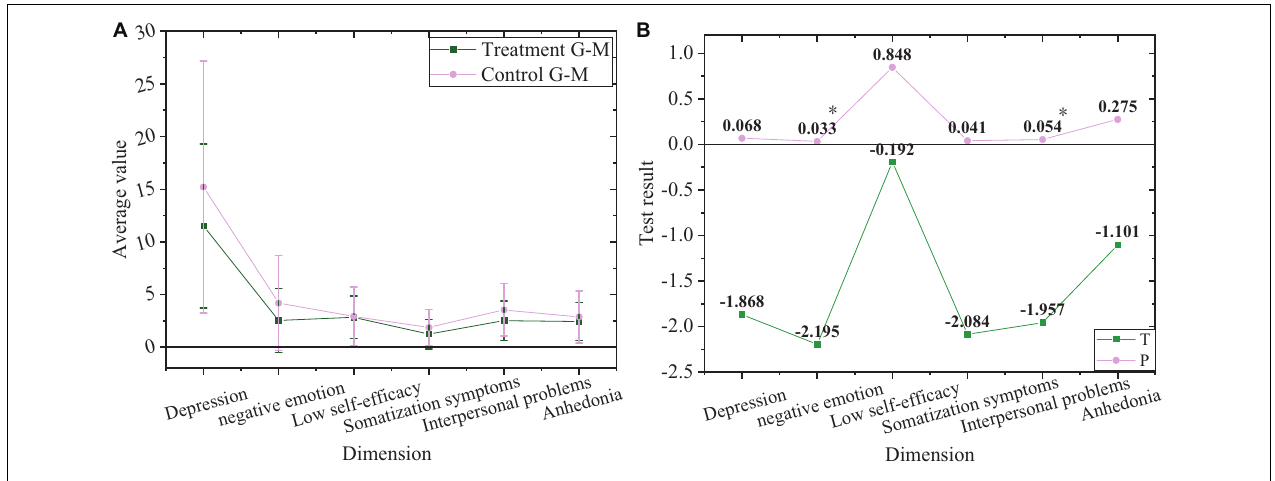
FIGURE 13 | Comparison of negative emotions. (A) Values of female subjects after the experiment. (B) Value of T and P of female subjects after the experiment. “ ∗ ”Represents a significant difference, while “ ∗∗ ” shows a highly significant